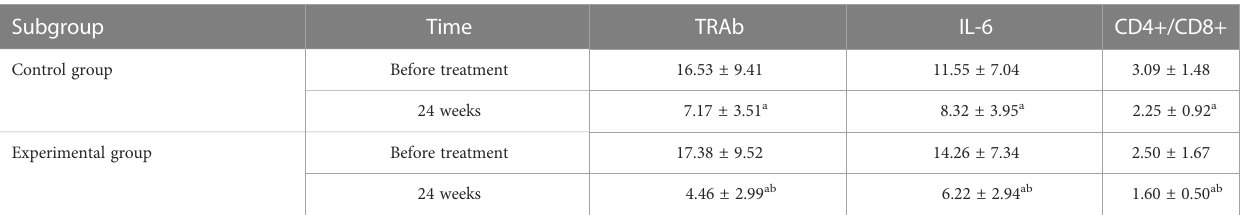
TABLE 4 Comparison of the immune function between the two groups of patients pre- and post-treatment.